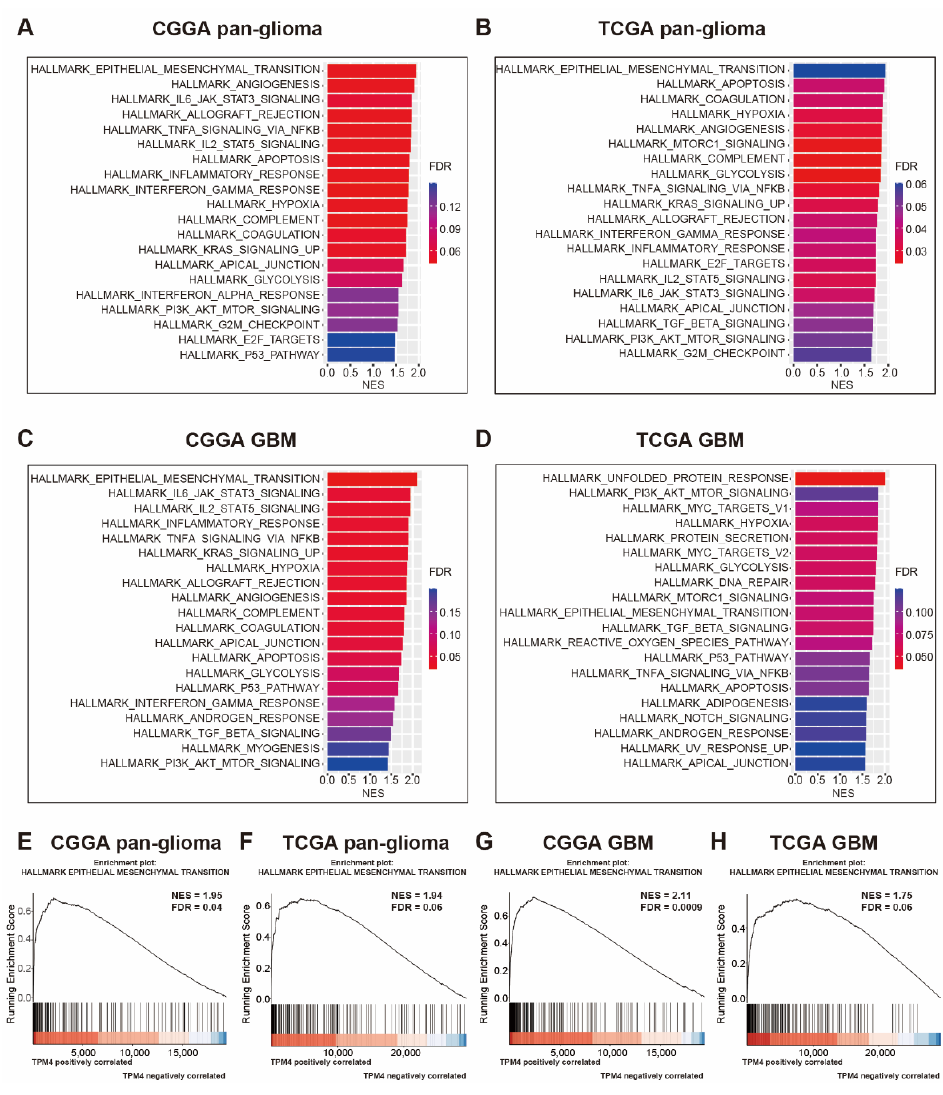
Figure 3. Gene set enrichment analysis (GSEA) for TPM4 in pan-glioma ( A , B ) and GBM ( C , D ), and GSEA plots for enrichment of epithelial-to-mesenchymal transition according to TPM4 expression in pan-glioma ( E , F ) and GBM ( G , H ). NES: normalized enrichment score; FDR: false discovery rate.